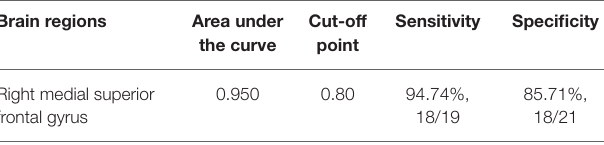
TABLE 4 | ROC analysis for differentiating patients from healthy